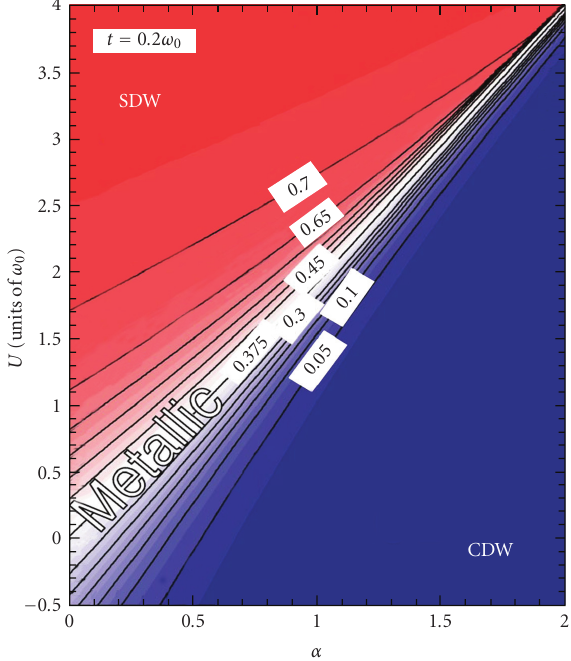
Figure 4: Contour plots of the local moment L 0 in ( α , U ) plane. Using (17) and (13), one can obtain contour plots for ( α , U ) for di ff erent values of L 0 . In Figure 4 we show these